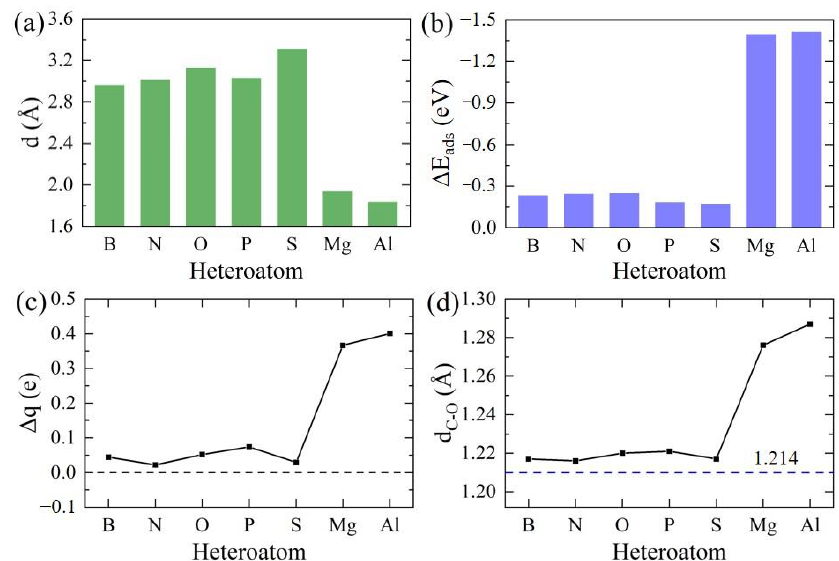
Figure 3. ( a ) The nearest adsorption distance between the heteroatom and HCHO molecule, ( b ) the adsorption energy of HCHO molecules on the XG substrate, ( c ) Bader charge gains ∆ q of HCHO molecule from the XG substrate, and ( d ) C–O bond length of HCHO molecule. The black dashed line in panel ( c ) indicates zero charge transfer, and the blue one in panel ( d ) denotes the C – O bond length of the free HCHO molecule.